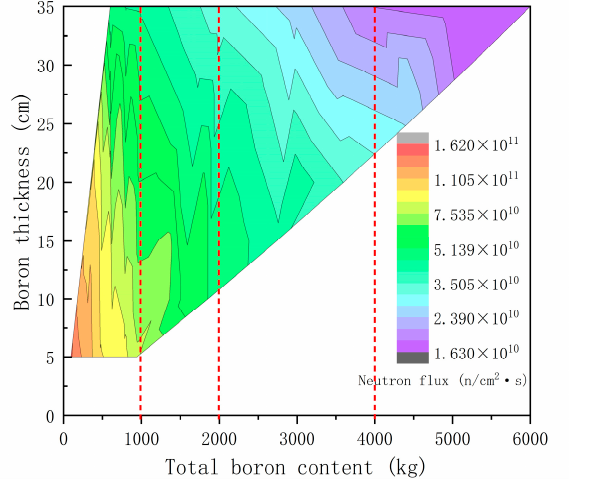
Figure 6. Total neutron flux ( a ) and gamma flux ( b ) on the outer side of the reactor vessel with different boron contents and boron graphite thickness.